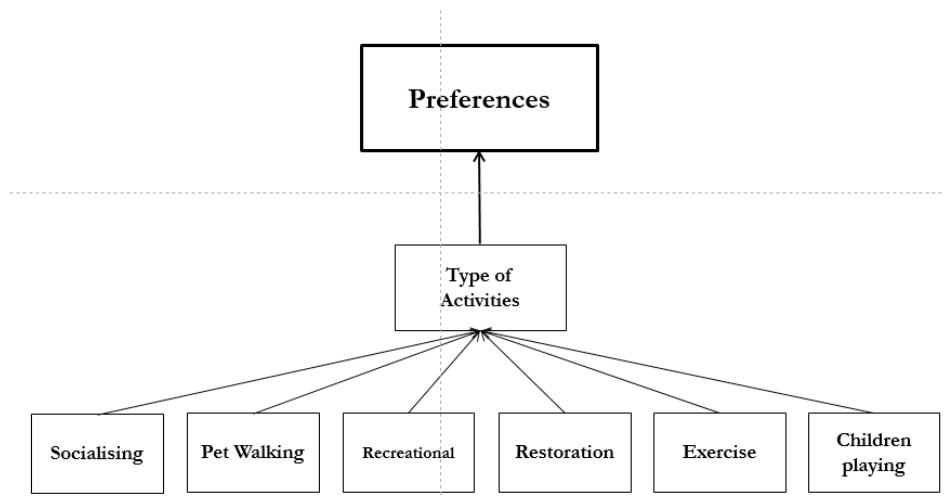
Figure 8: Type of activities and its contribution to greenspaces